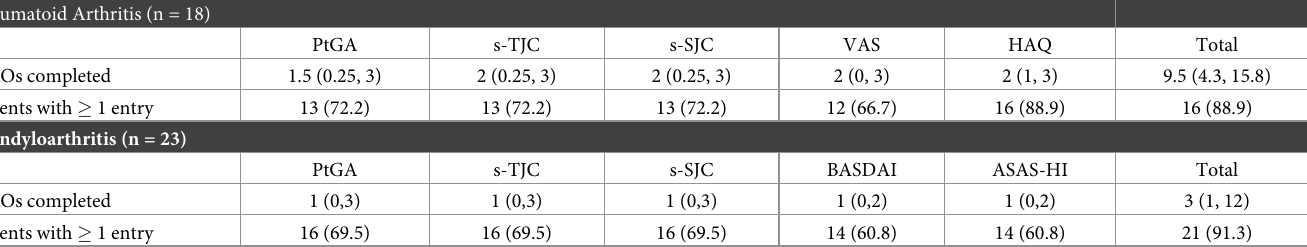
Table 2. Onboarded patient engagement with regards to ePROs. Rheumatoid Arthritis (n =